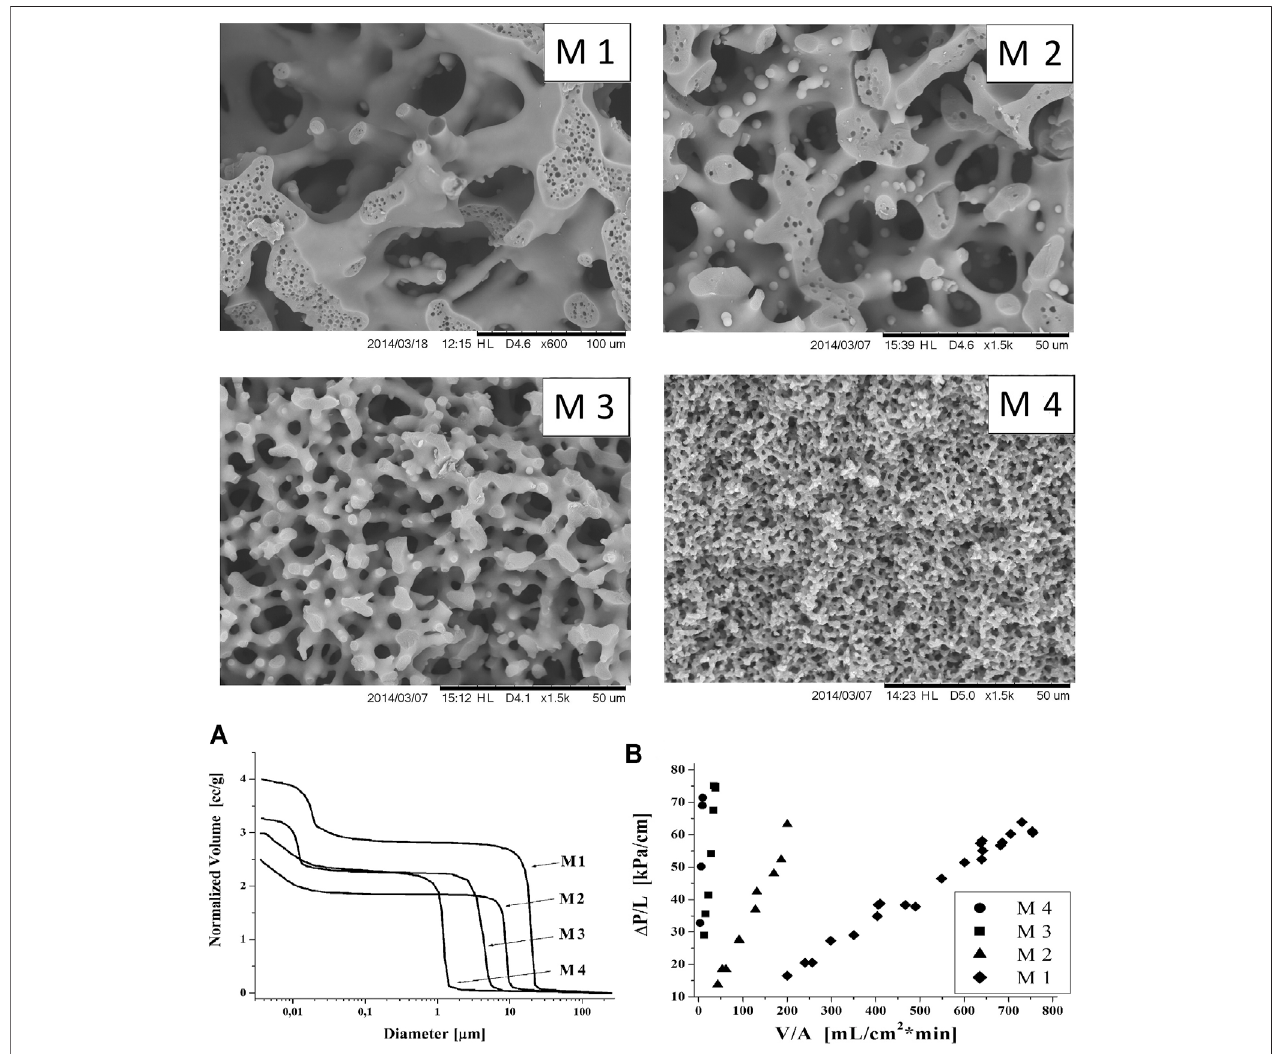
FIGURE 2 | SEM images of silica monoliths with different pore structures; cumulative pore volume distributions obtained from Hg-porosimetry (A) ; effect of back- pressure on the fl ow rate for M1 – M4 monoliths (B) .